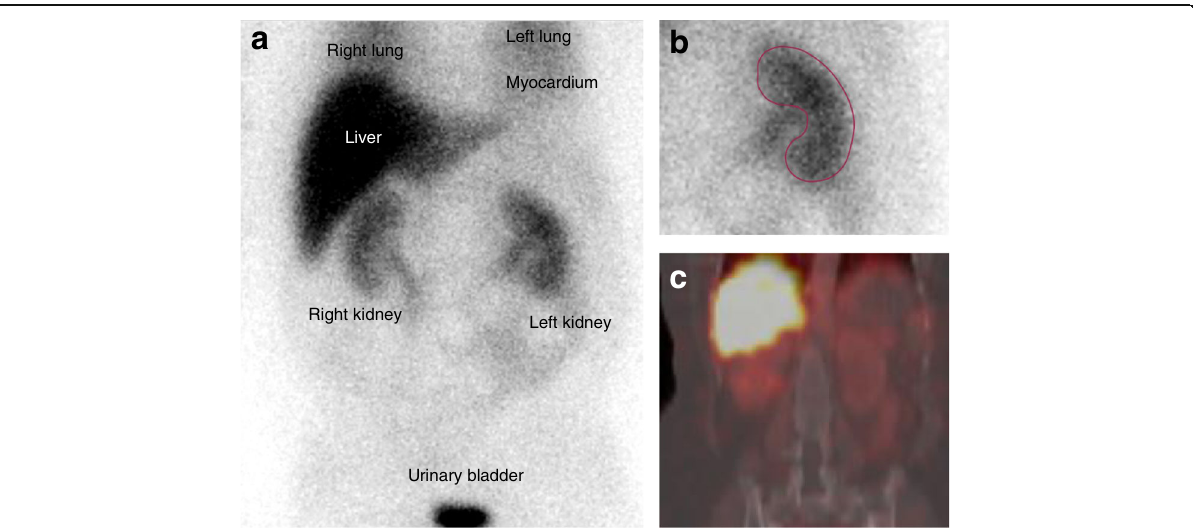
Fig. 1 Anterior planar and SPECT-CT 123 I – m IBG scintigraphy. The planar image ( a ) shows clear uptake of 123 I – m IBG uptake in various organ: liver, urinary bladder and evident uptake of 123 I – m IBG in both kidneys. b Shows the ROI on the planar image of the left kidney trying to exclude any pelvic activity. c Shows a coronal slice of the SPECT-CT showing the proximity of the liver to the right kidney. The proximity of the liver to the right kidney can also be appreciated on the planar images ( a ). Thereby, both planar and SPECT images illustrate the possible impact of liver activity on parameters of 123 I – m IBG uptake in the right kidney